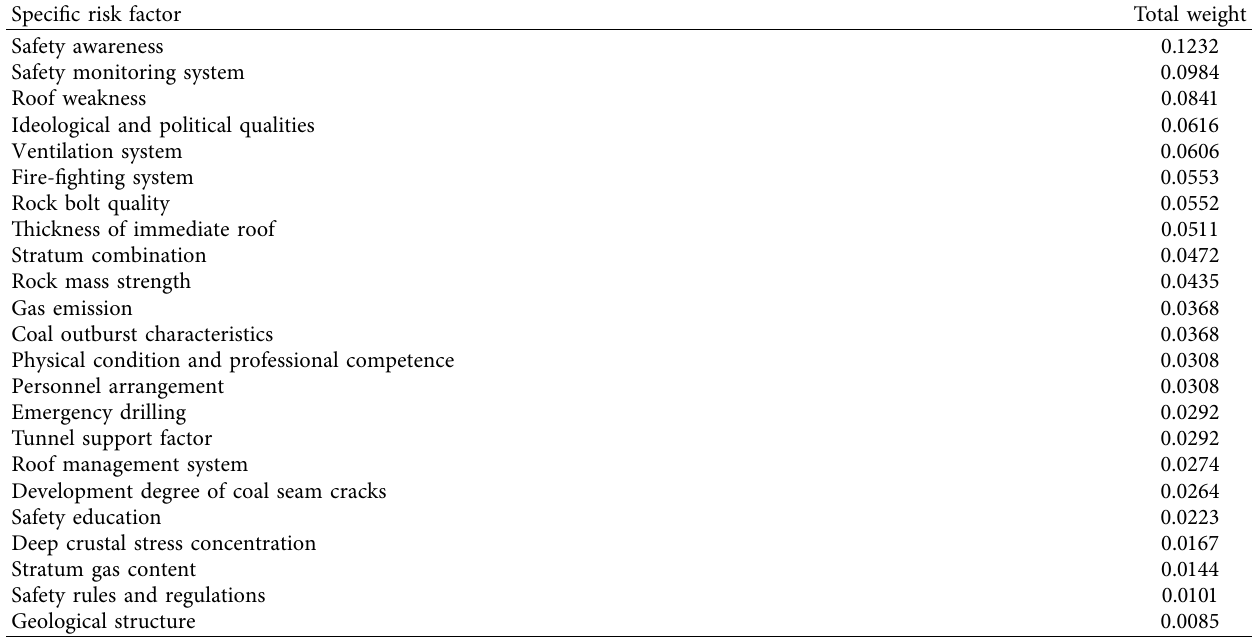
Table 8: Total ranking of risk